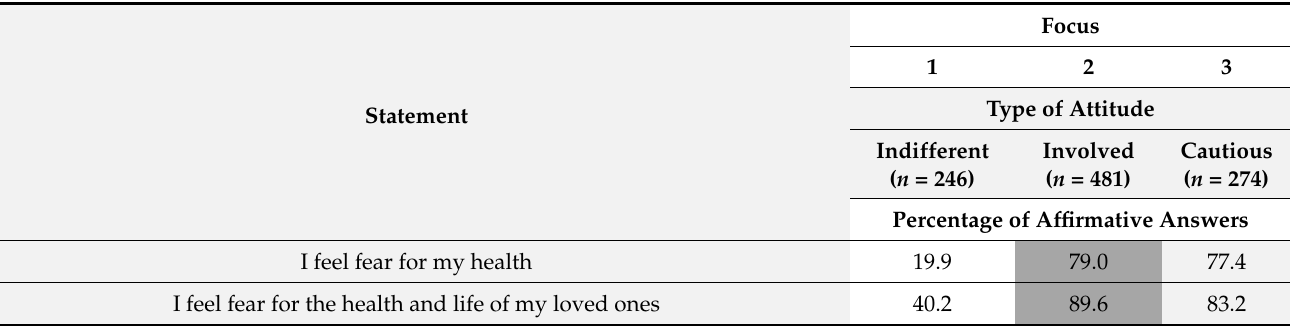
Table 1. Percentage of affirmative answers (Definitely yes and Probably yes) for the three attitude